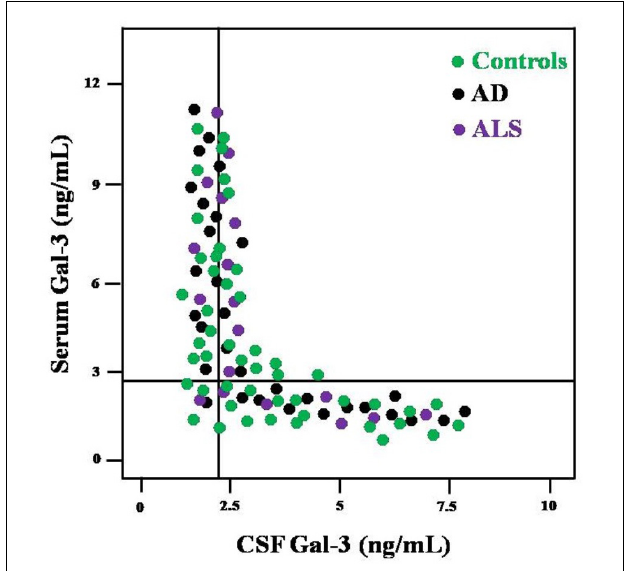
FIGURE 1 | Distribution of AD, ALS and control subjects according to the values of CSF Gal-3 ( x -axis) and serum Gal-3 ( y -axis).